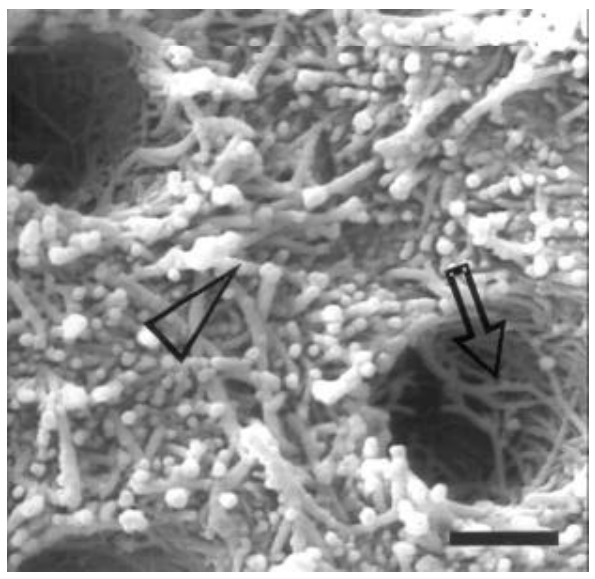
FIGURE 2 - Cross-sectioned tubules showing intense exposed peripheral intertubular collagen fibers (arrow) and outer peritubular collagen fibrils (arrowhead) (20 years old) (Bar = 1 µm / 10,000 X)